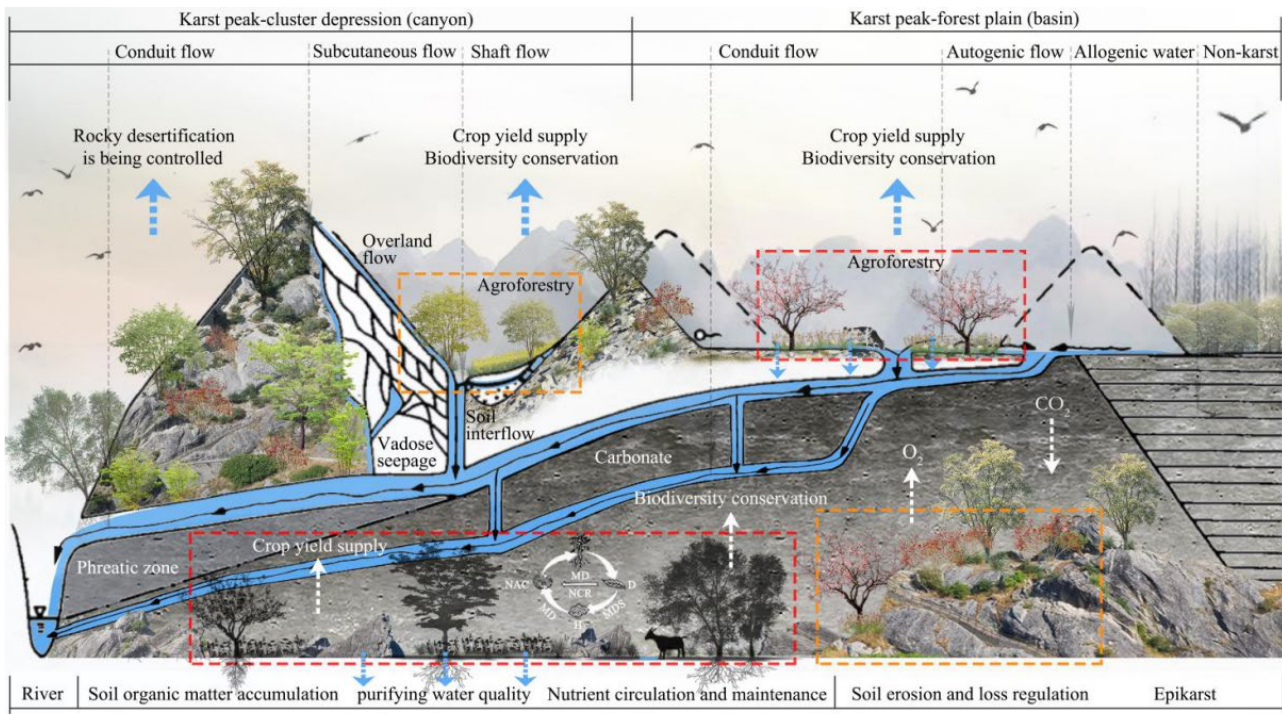
Figure 1. Schematic diagram of agroforestry complex ecosystem in the KRD area, showing the supply services that agroforestry has in the KRD area with high landscape heterogeneity, and its different benefits under different habitat types. (NCR, nutrient cycling and retention; MDS, microbial decomposition synthesis; NAC, nutrients available to crops; MD, microbial decomposition; D, defoliation; H, humus).